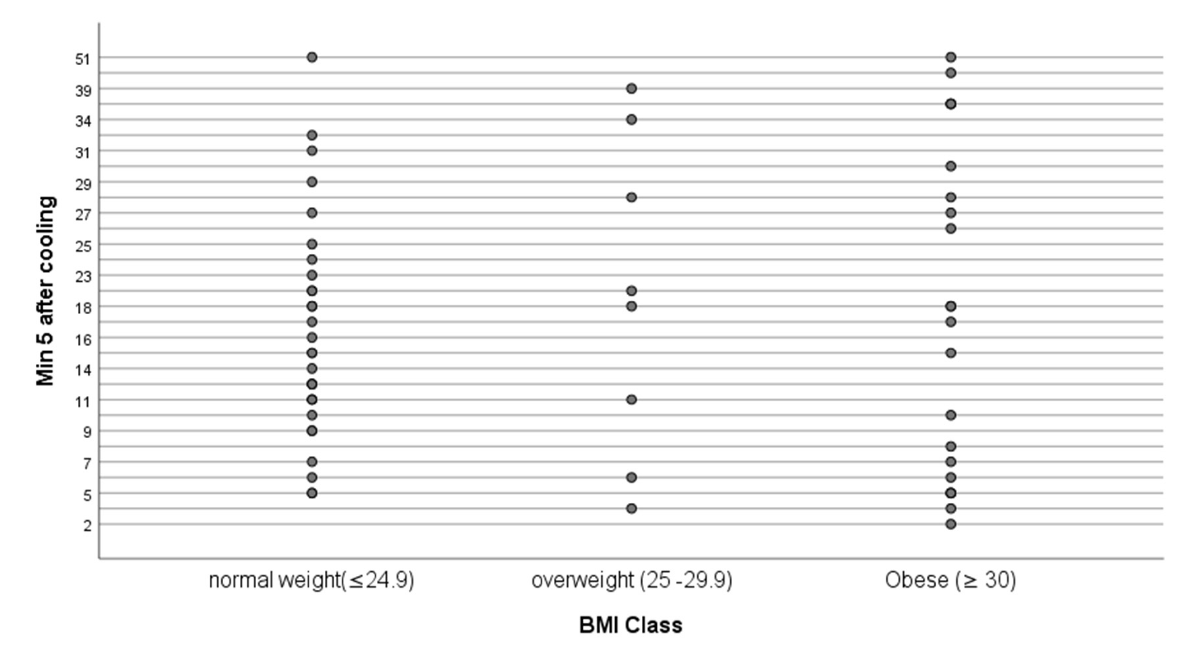
Figure 5. Hot spot count at 5 min after the end of cooling by BMI Class . BMI, kg/m 2 .